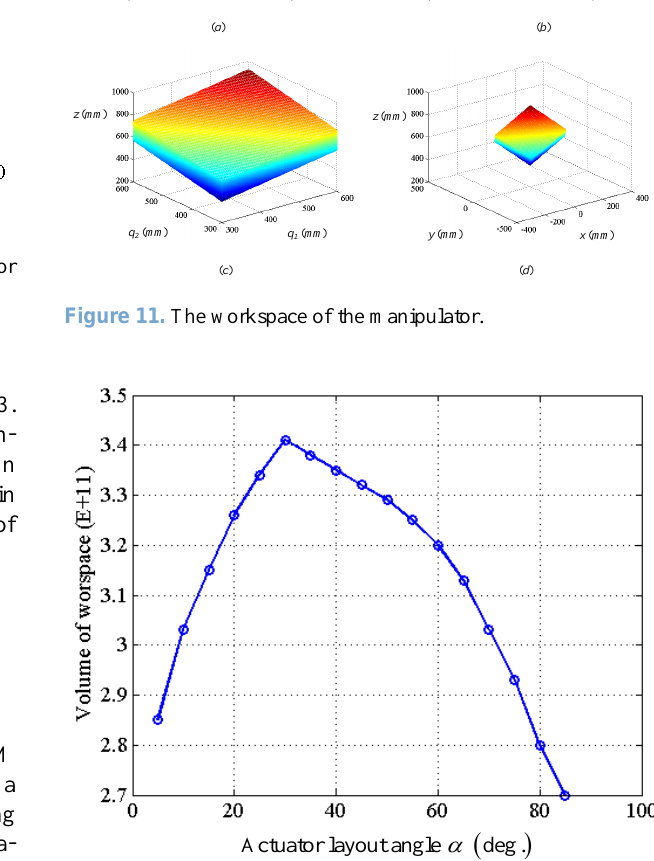
Figure 12. Reachable workspace volume versus actuator layout an-